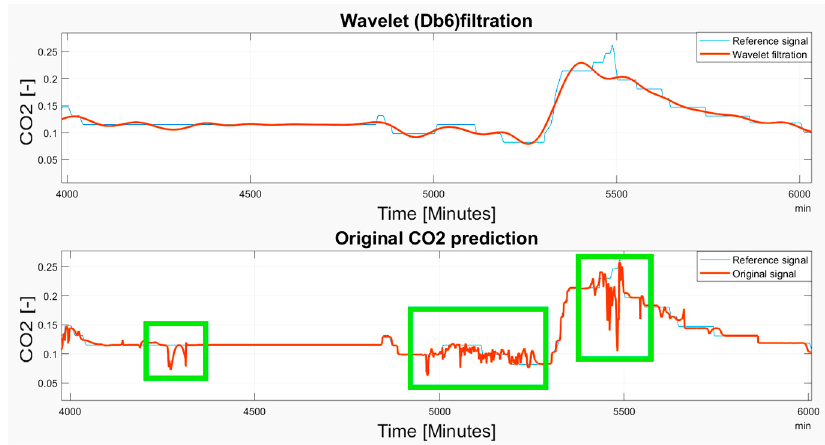
Figure 21. The 6–13 November 2018 prediction of the CO 2 signal containing several glitches and signal spikes, marked as green rectangle.